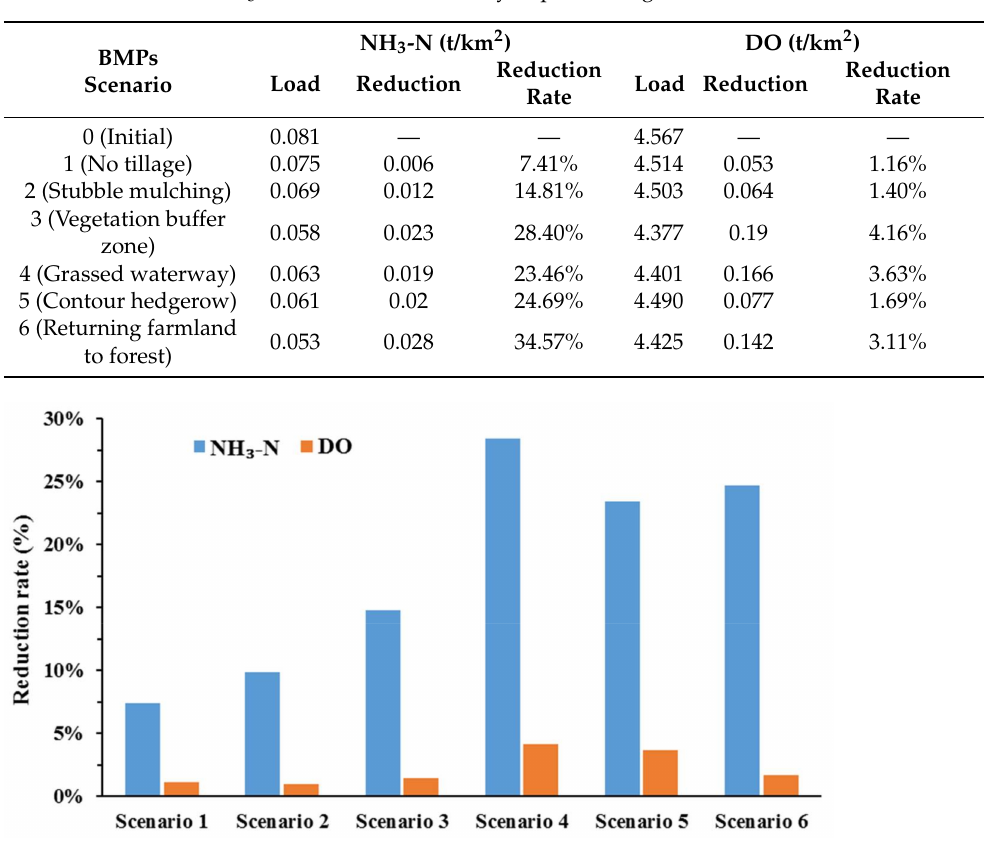
Figure 10. Reduction rate of NH 3 -N and DO load by implementing BMPs in different